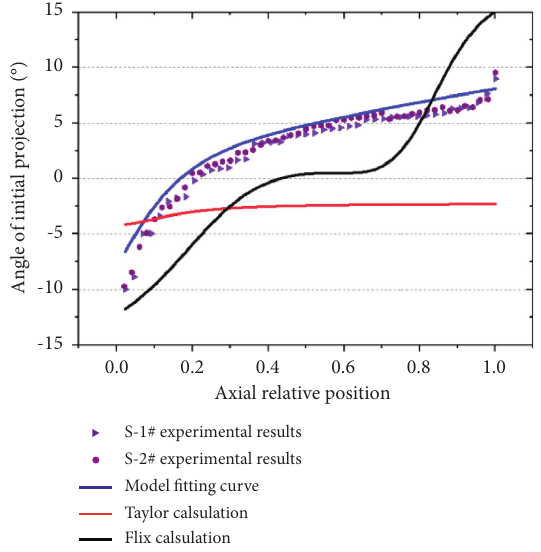
Figure 14: Comparison of empirical